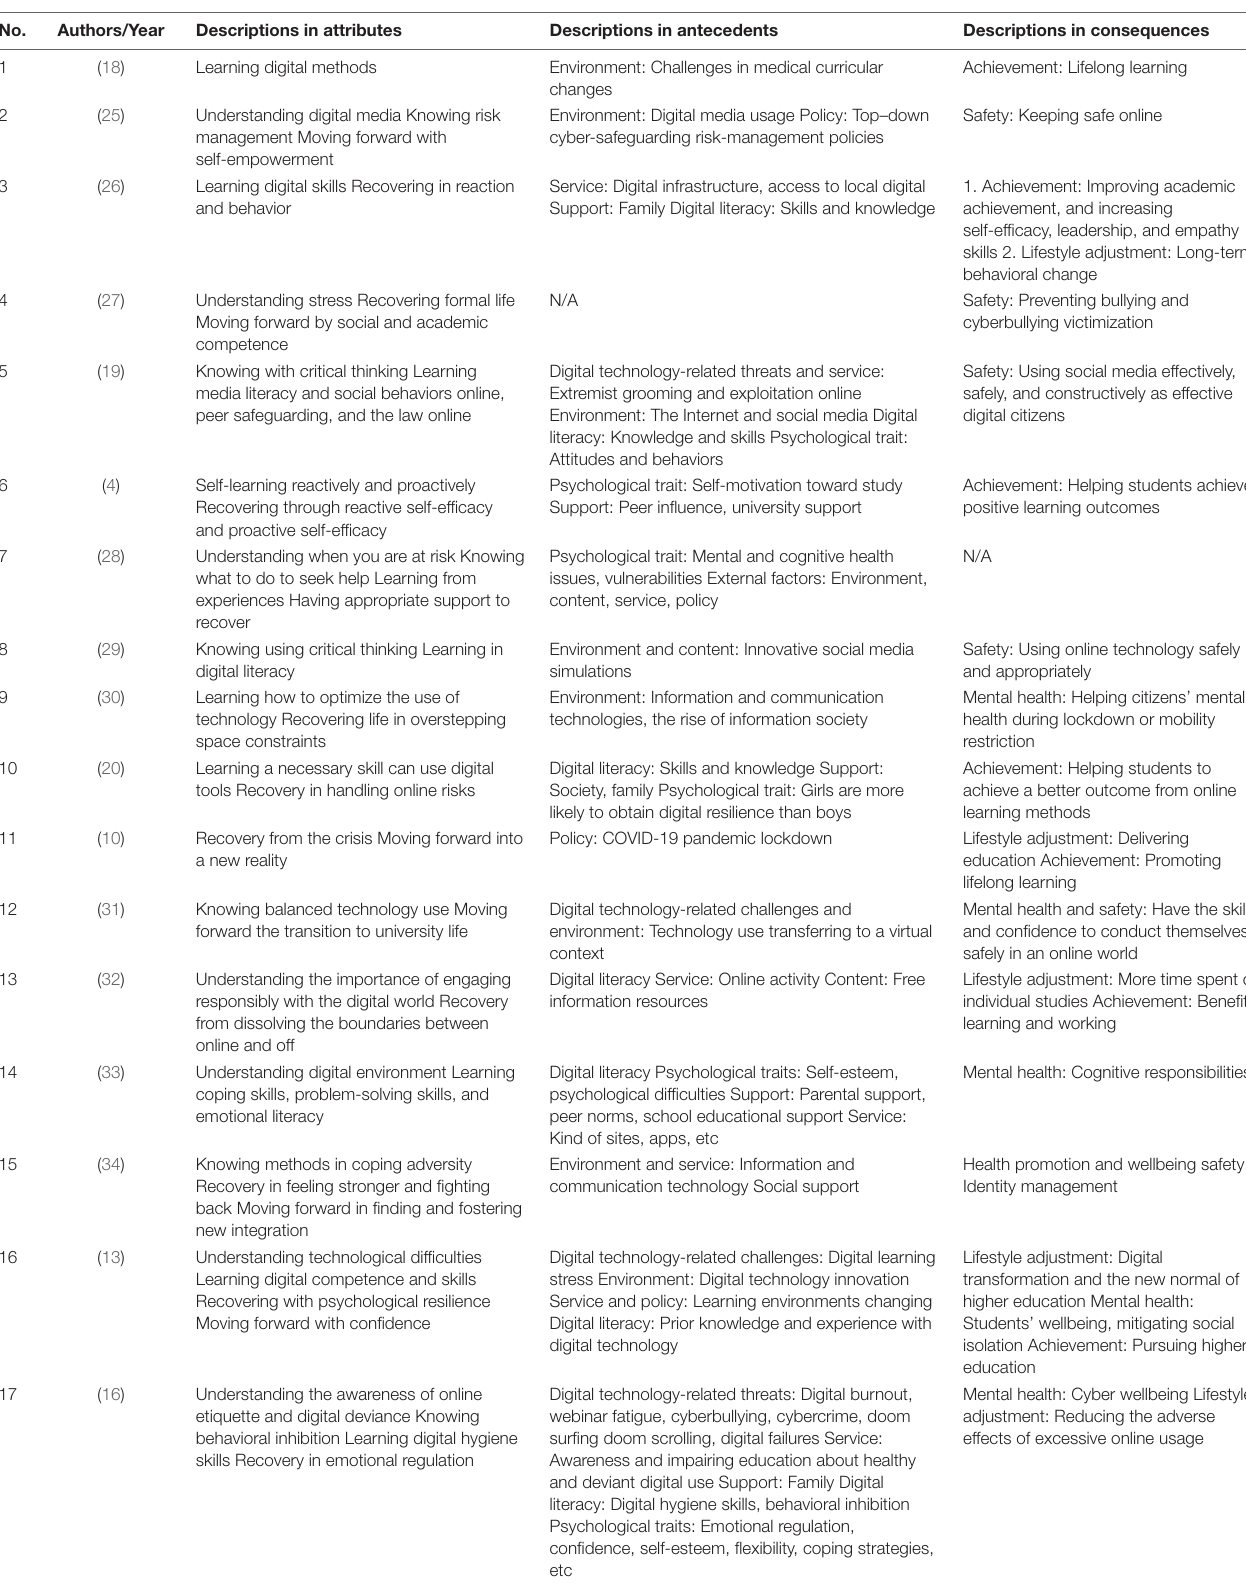
TABLE 3 | Attributes, antecedents, and consequences of digital resilience in the included studies.